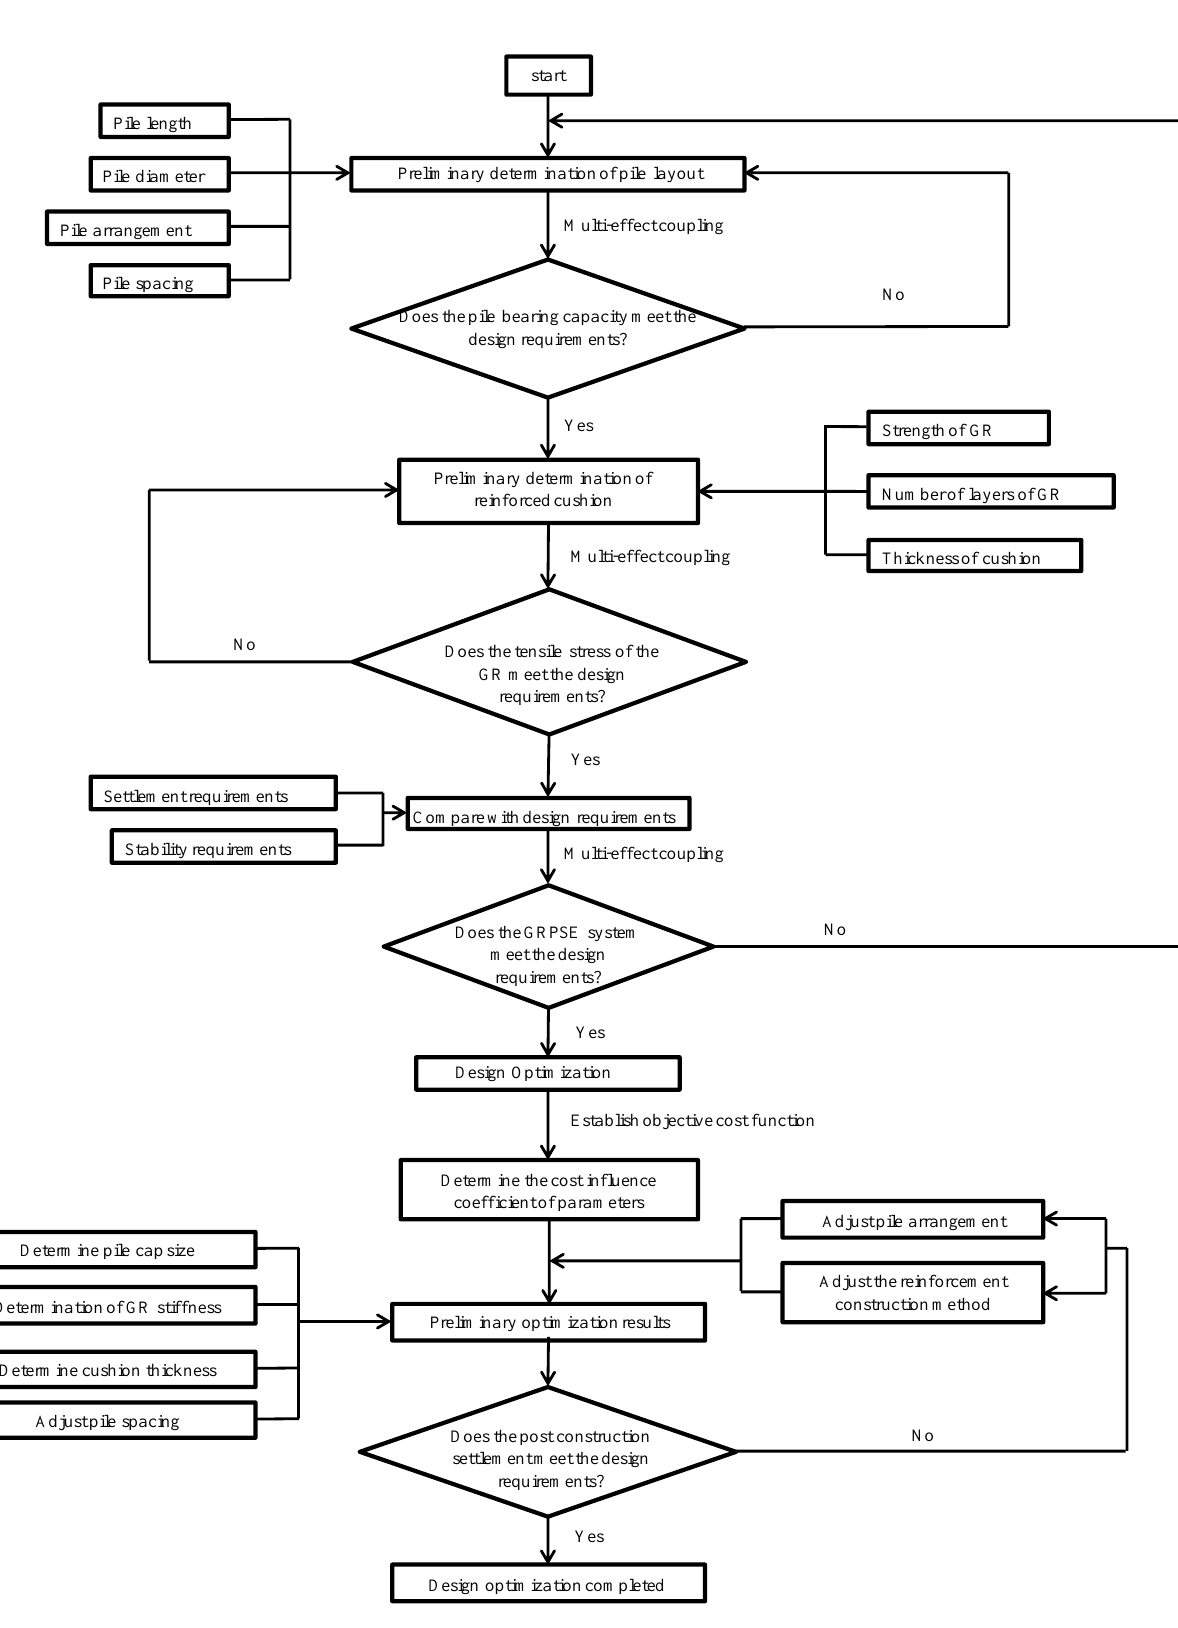
Figure 6. Optimization process of GRPSE system proposed in this study. Select pile type and construction materials based on the engineering